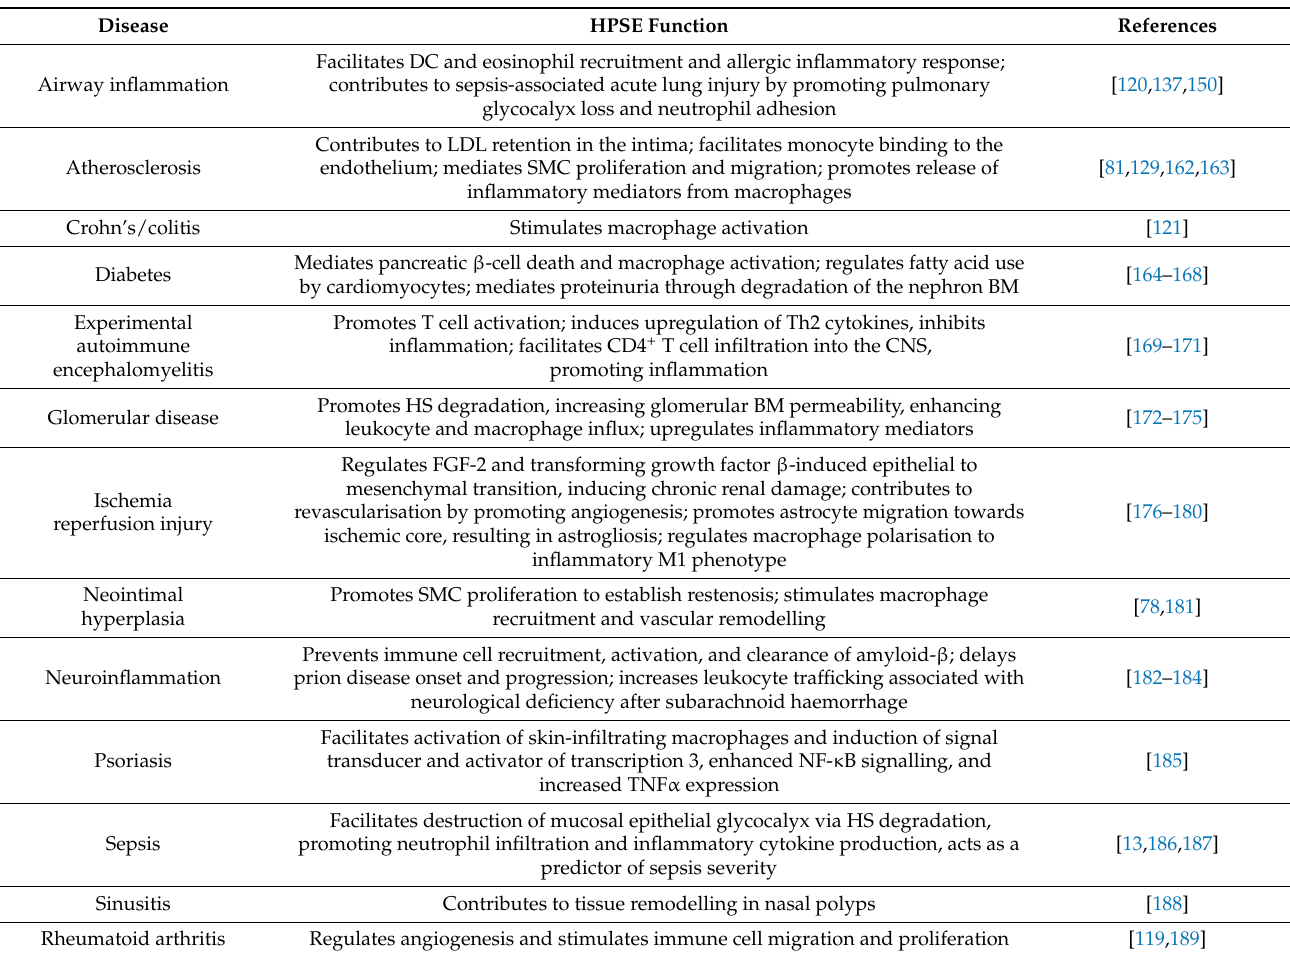
Table 2. HPSE functions in disease